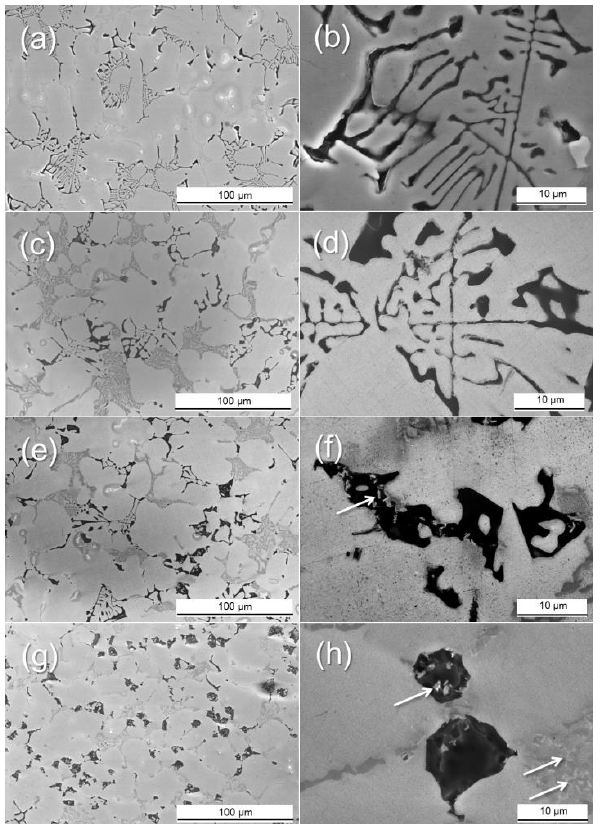
Figure 2. SEM images of the eutectic Al + Mg 2 Si phases of the Al–8Zn–6Si–4Mg–2Cu alloy with different Ti amounts: ( a , b ) without Ti; ( c , d ) at 0.1% of Ti; ( e , f ) at 0.5% of Ti; and ( g , h ) at 1% of Ti. Here, the white arrows indicate the TiB 2 particles.